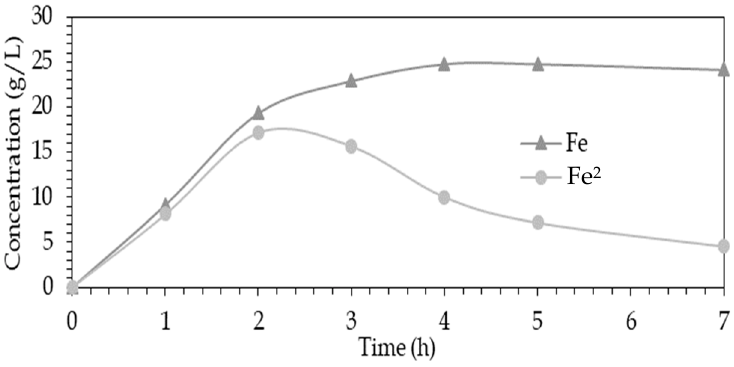
Figure 7. Concentration of iron and ferrous ions over time in test P5.